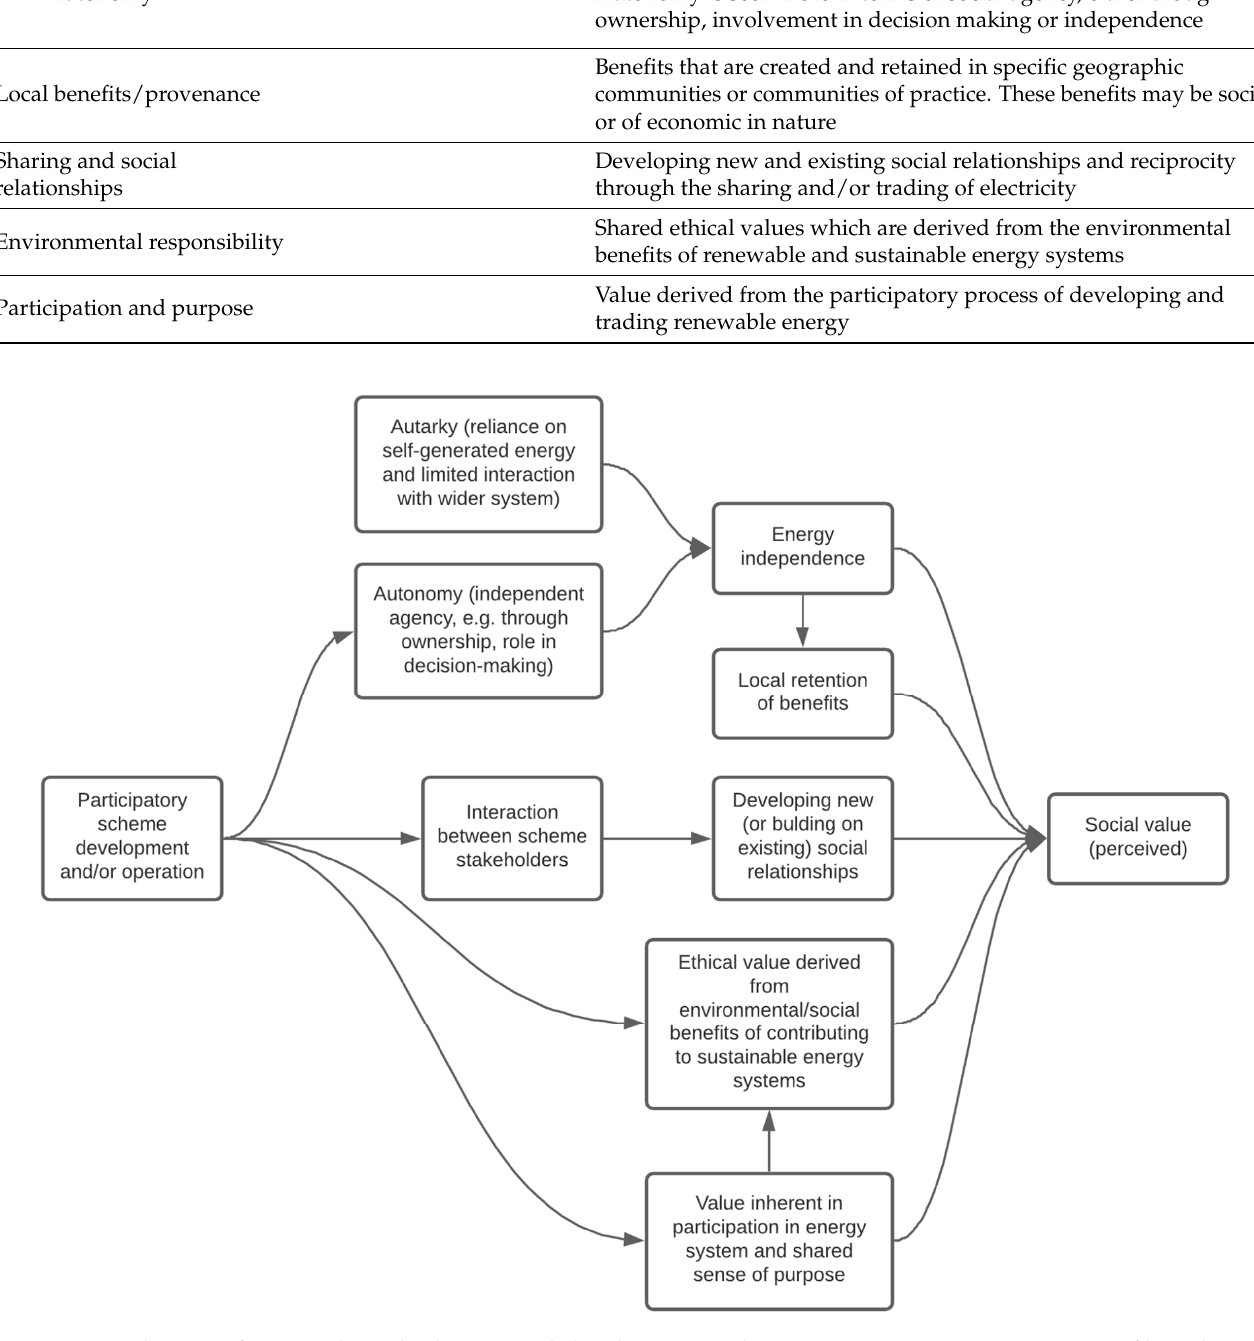
Figure 5. Elements of perceived social value as revealed in this review. The arrows represent our interpretation of how they are likely to relate to each other.